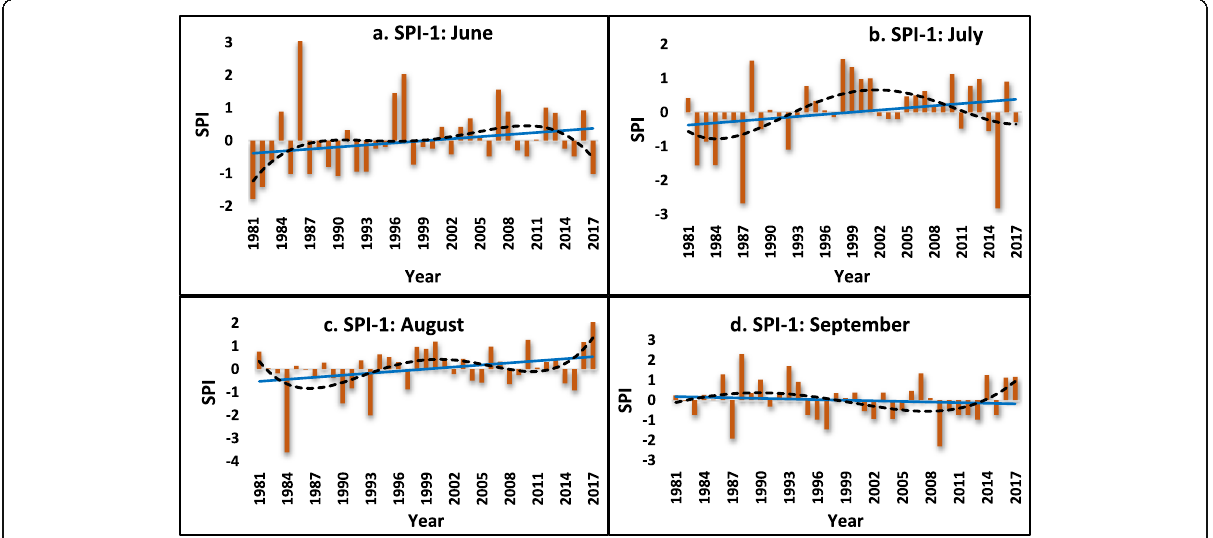
Fig. 3 SPI 1-month anomalies and trends of kiremt rainy months: ( a ) SPI-1: June; ( b ) SPI-1: July; ( c ) SPI-1: August; ( d ) SPI-1: